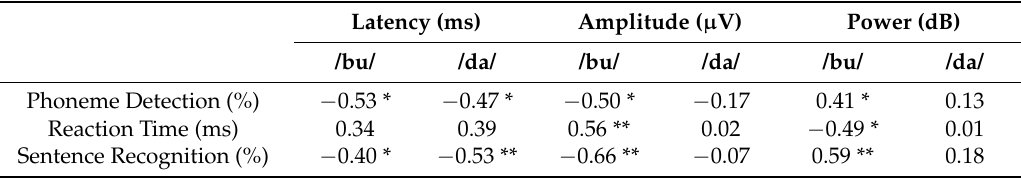
Table 3. Correlation coefficients for brain-behavior correlations between neural MMN latency, amplitude, and theta power for /bu/ and /da/ at electrode Cz and behavioral phoneme detection percent correct, reaction time, and percent correct sentence recognition scores.